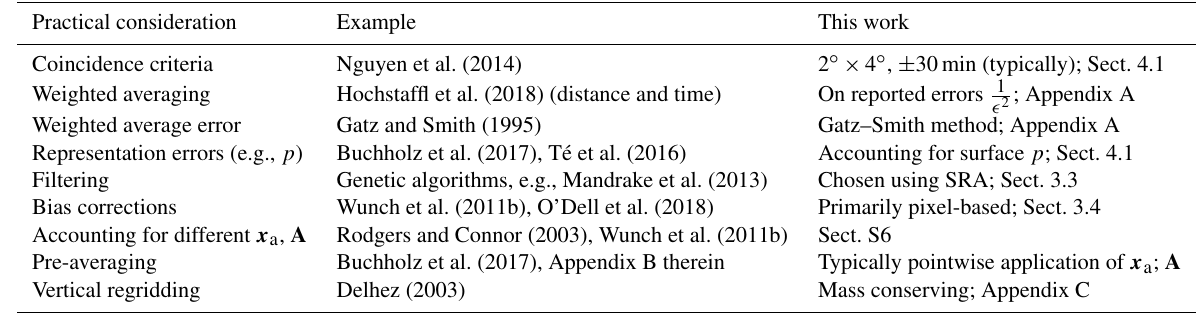
Table 6. Summary of practical considerations comparing MOPITT and TCCON soundings.